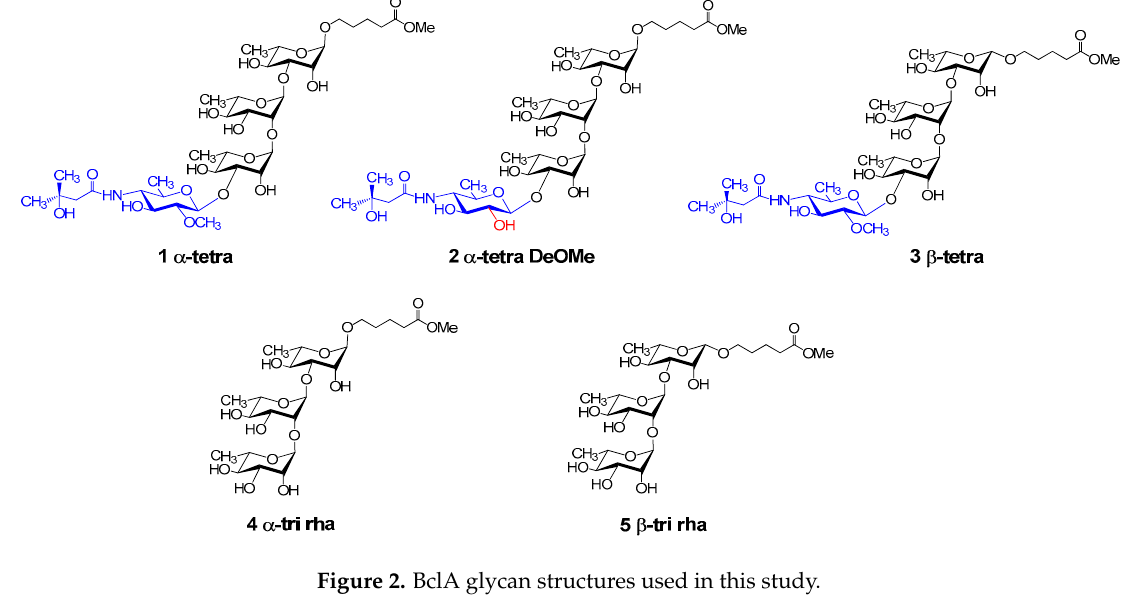
Figure 2. BclA glycan structures used in this study.